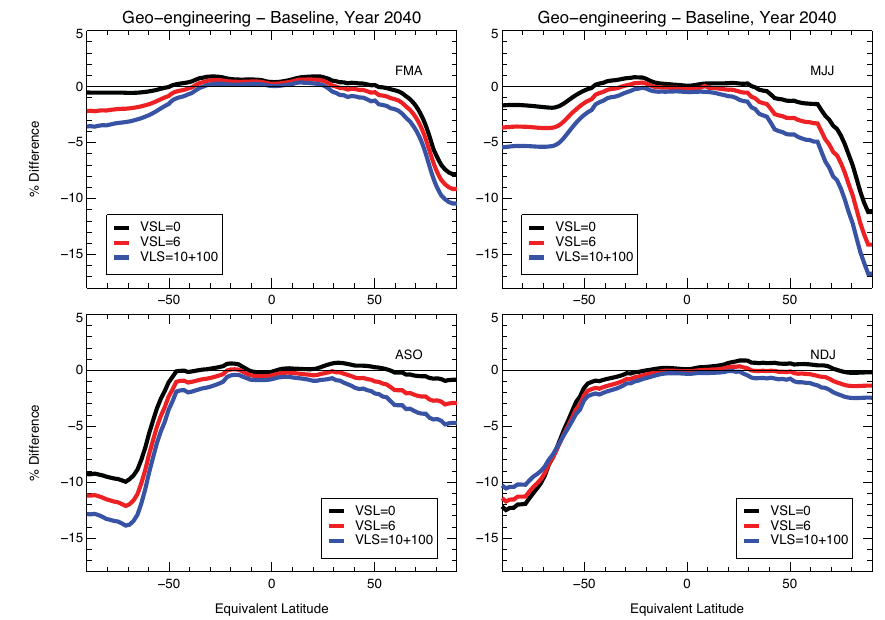
Fig. 2. Relative difference of column ozone between geo-engineering and baseline model results for four seasons (different panels). All calculations are for year 2040. Different values of VSL halogens are considered: Br VSL y and Cl VSL y both = 0 (black), Br VSL y = 6ppt and Cl VSL y = 0 (red), and Br VSL y = 10ppt and Cl VSL y = 100ppt (blue). Results are shown as a function of equivalent